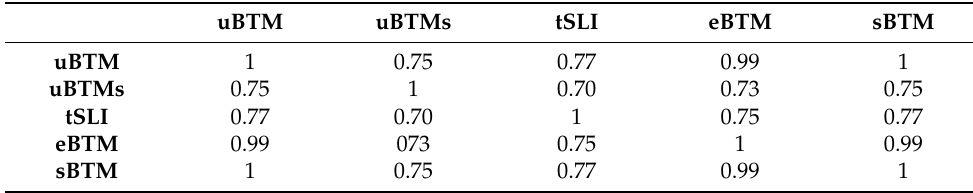
Table 2. Correlation matrix of models on the coast